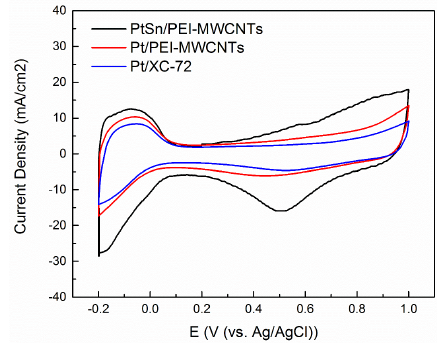
Figure 7. Cyclic voltammograms of Pt/XC72, Pt/PEI ‐ MWCNTs and PtSn/PEI ‐ MWCNTs catalysts in 0.5 M H 2 SO 4 at a scan rate of 50 mV/s.